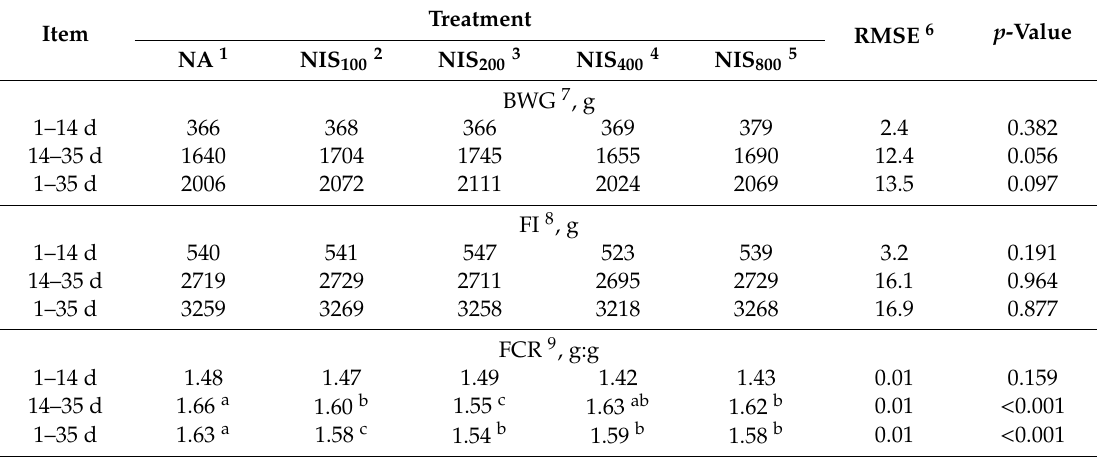
Table 9. The e ff ect of dietary supplementation of nisin on the growth performance of broiler chickens, Experiment 2.